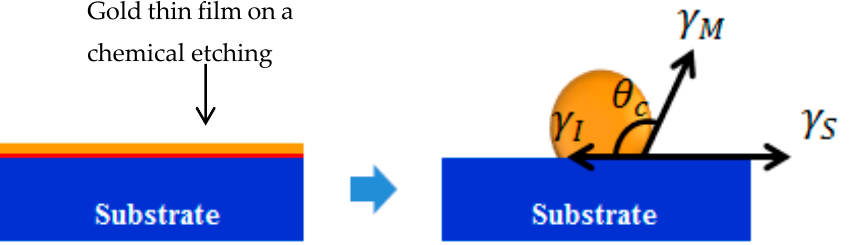
Figure 8. Schematic illustration of gold nanoisland formation on an assisted chemical etching glass substrate at 700 ◦ C.